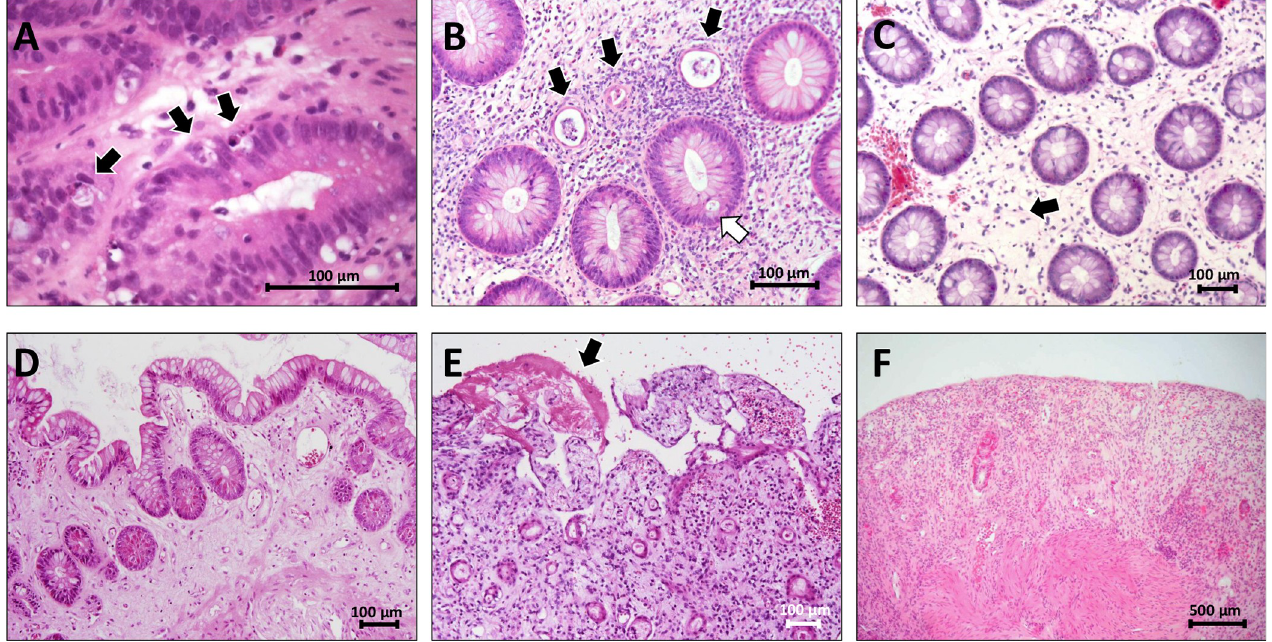
Fig 1. Histology of acute graft-versus-host disease of the colon. Crypt cell apoptosis: Apoptotic bodies consist of cell debris visible as dark particle in a lighter background (arrows) (Lerner grade 1, Sales grade 0, Melson grade 1. HE) (A). Crypt destruction: Degeneration of crypt epithelial cells, the lumen is filled with cell detritus and a few granulocytes (black arrows); a neighboring crypt exhibit an apoptotic body (white arrow) (Lerner grade 2, Sales grade 1, Melson grade 1. HE) (B). Individual crypt loss: Gap between preserved crypts the size of one crypt (arrow) (Sale grade 2, Melson grade 2), there is no crypt cell apoptosis or ongoing crypt destruction visible (therefore Lerner grade 0. HE) (C). Contiguous crypt loss: Wide gaps between residual crypts, Paneth cell metaplasia in the remaining crypts indicates chronic mucosa injury (Lerner grade 0 (because there is no ongoing destruction of crypt epithelial cells), Sales grade 3, Melson grade 3. HE) (D). Mucosa denudation: Loss of the superficial epithelial layer and fibrin deposit (arrow) (Lerner grade 3) and contiguous crypt loss (Sales grade 3, Melson grade 3. HE) (E). Diffuse mucosa denudation: Exhaustive mucosa destruction with near complete crypt loss (Lerner grade 4, Sales grade 4, Melson grade 4. HE)